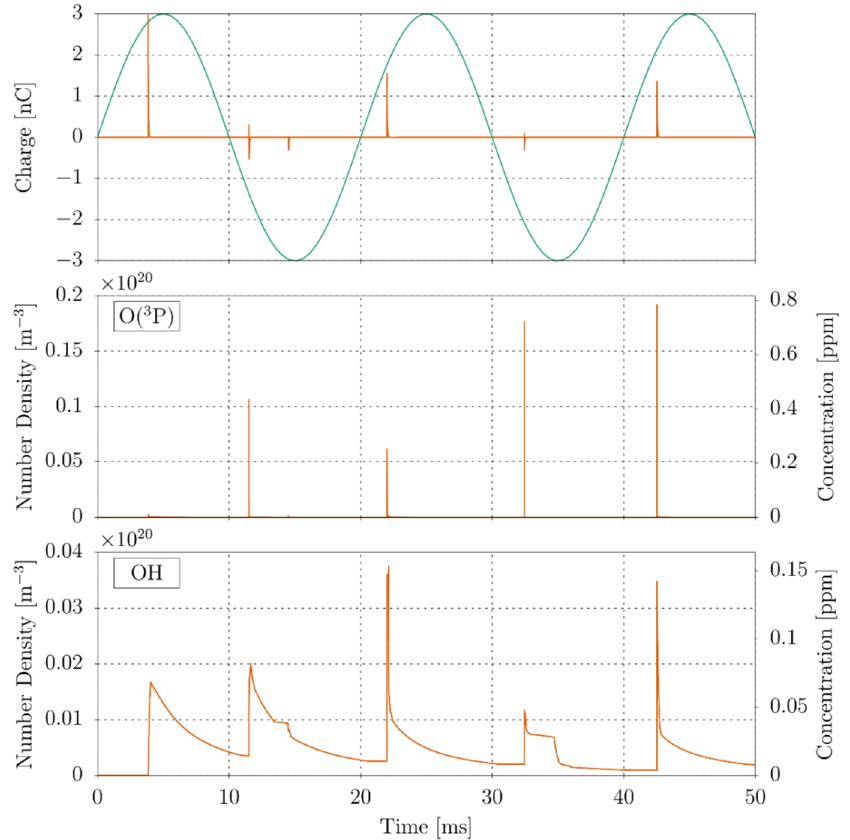
Figure 10. Temporal evolution of the electric current ( top ), oxygen atom ( middle ), and hydroxyl radical ( bottom ).